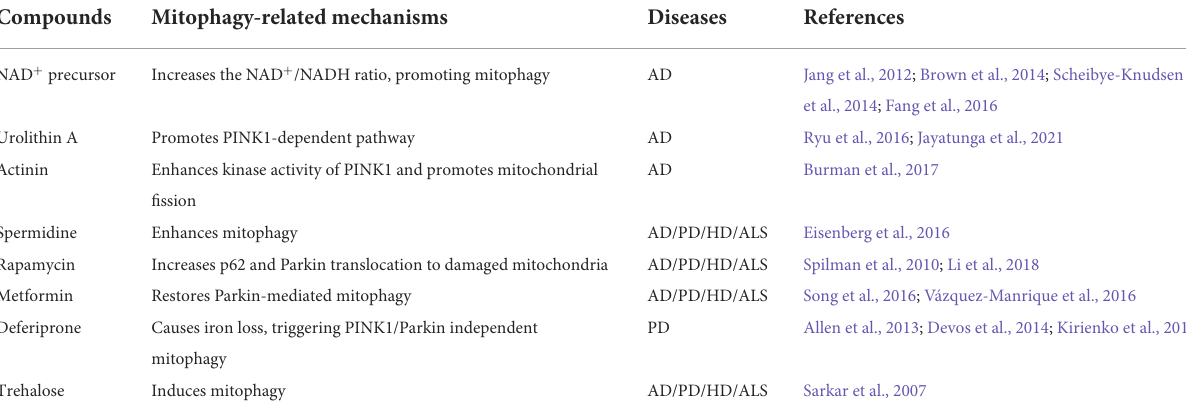
TABLE 1 Compounds targeting mitophagy and their